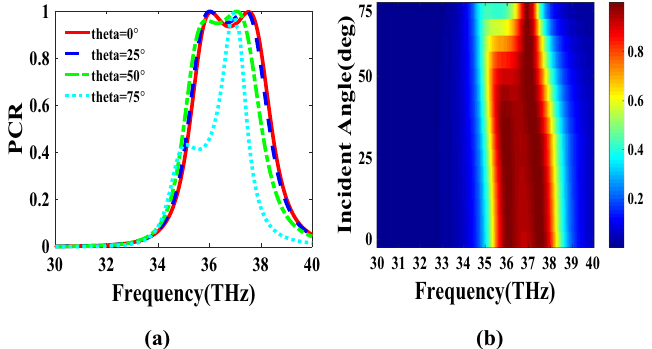
Figure 19. PCR of the third structure for different incident angles.